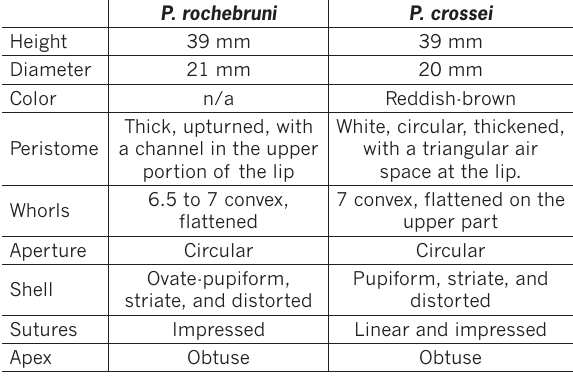
Table 1. GenBank accession numbers for all taxa included in the phylogenetic